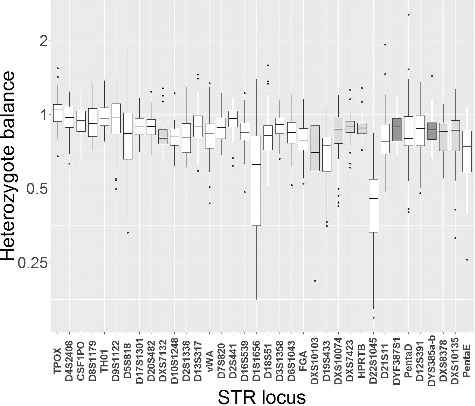
Heterozygote balances of the STRs. The loci are listed according to increasing PCR amplicon size from left to right. Autosomal loci are marked with white colour, X-chromosomal loci with pale grey colour and Y-chromosomal loci with dark grey colour (two amplicons are generated from each of the Y-STRs DYF387S1 and DYS385a/b). The box-and-whisker plot parameters are described in Figure 1.